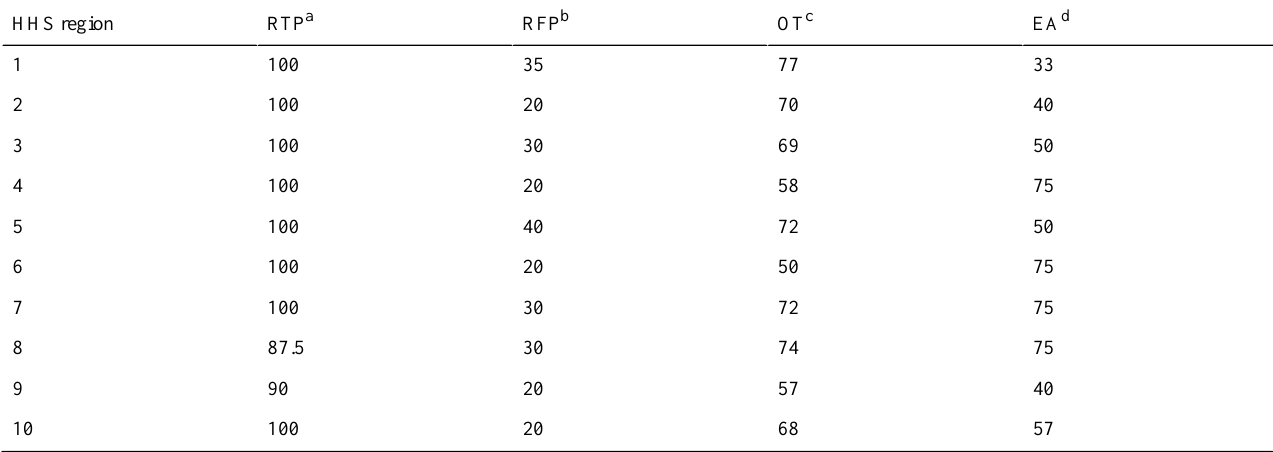
Table 6. Result of Poisson outbreak detection for all performance metrics across all Department of Health and Human Services (HHS) regions of the United